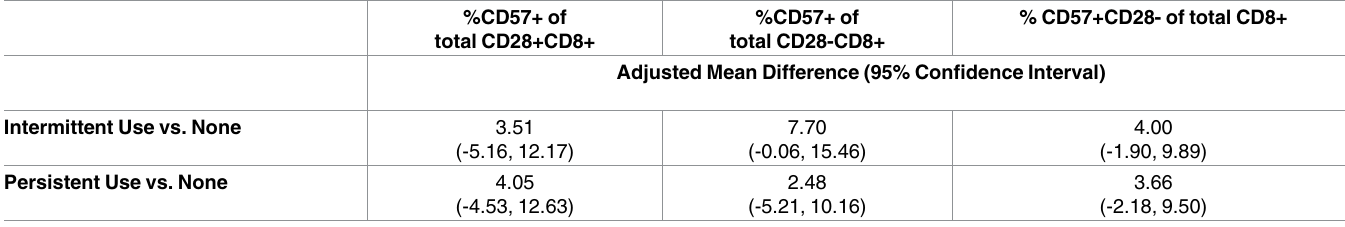
Table 6. Association between pattern of illicit opioid use and CD8 T cell senescence, linear regression models *